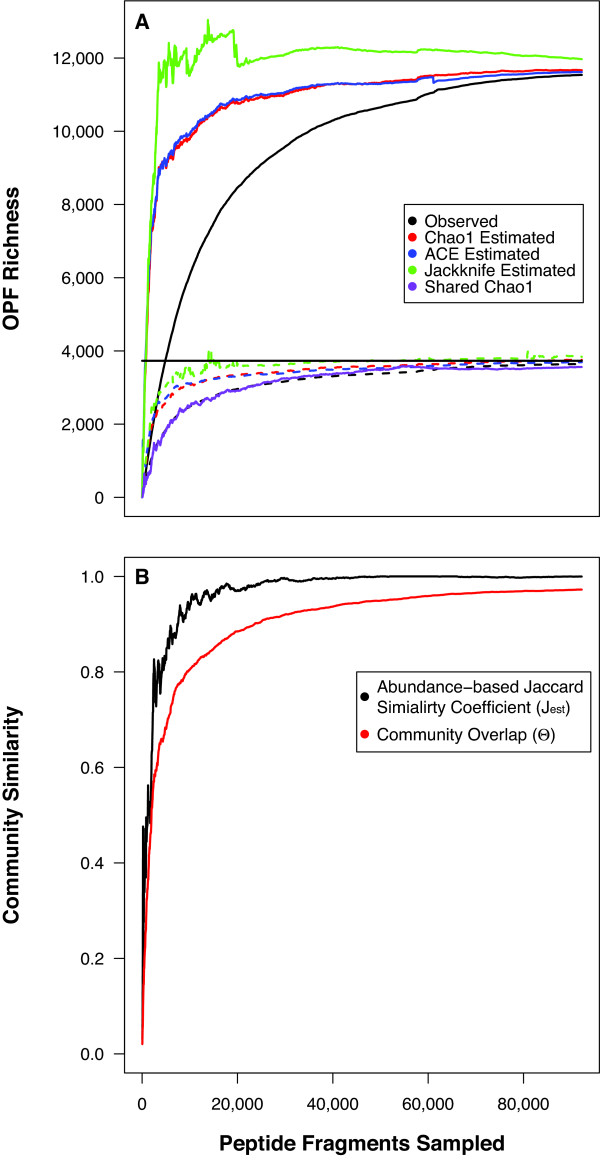
Analysis of the richness and community membership when peptide fragments identified in individual sequence reads were used to assemble the Bacillus anthracis str. Ames genome sequence. (A) The collector's curves for three non-parametric richness estimators and observed richness using individual sequence reads compared to the OPF richness of the assembled genome (horizontal black line). The solid lines represent the richness of non-merged OPFs and the dashed lines represent the richness of merged OPFs with a penalty of 0.15. (B) Collector's curves of parameters describing the similarity between two randomly selected subsets of peptide fragments.